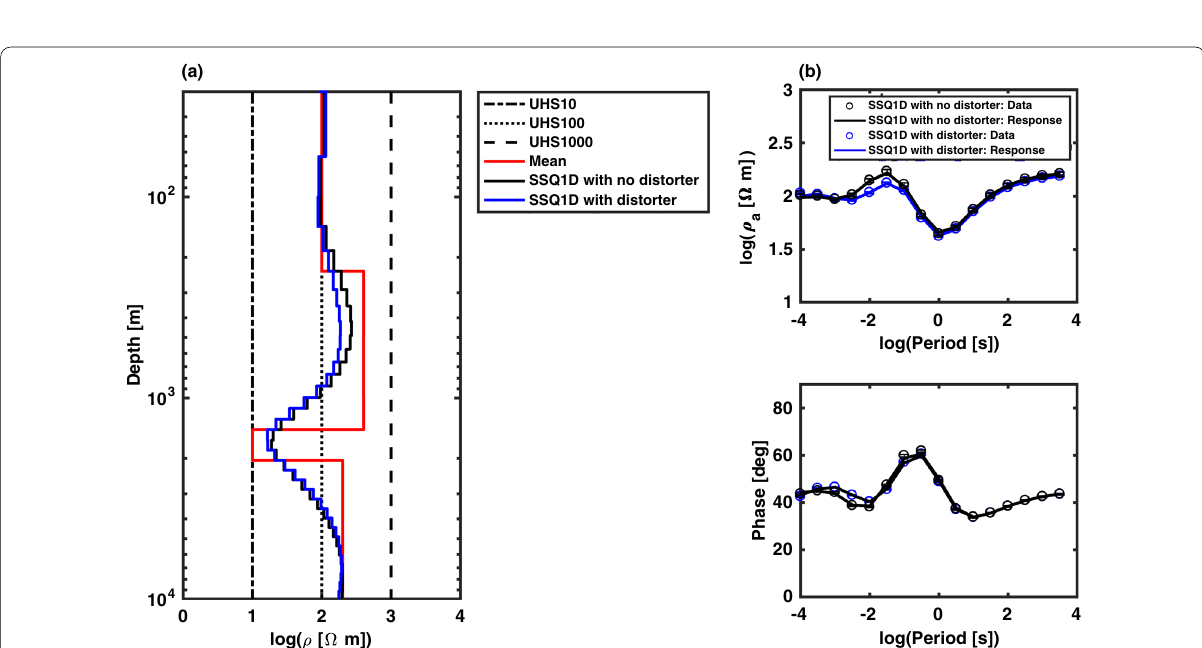
Fig. 24 a Regional mean 1D resistivity profile estimated from the average ssq impedance (SSQ1D, solid blue line) from the oblong distorter model, which was used as the initial and prior models in 3D inversion. The SSQ1D model is compared with the areal average of the synthetic model (red solid line), the SSQ1D model without distorters (solid black line), UHS10 (dashed–dotted line), UHS 100 (dotted line), and UHS1000 (dashed line). b Synthetic data (blue circles) and inversion responses (blue solid curves) corresponding to the SSQ1D model from the case with distorters. They are shown in comparison with corresponding responses for the case without